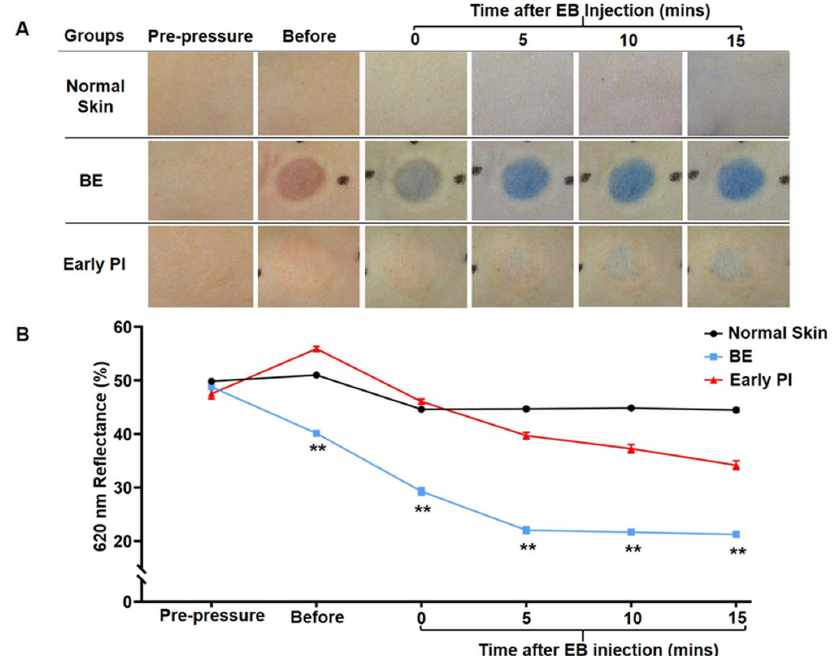
Figure 3. Analysis of BE and early PI after EB injection: ( A )representative pictures of BE and early PI before and after EB injection. EB solution was injected at 0, 5, 10, and 15 min post-decompression. Normal skin was observed as a normal reference; ( B ) reflectance represented the spectroscopic measurement of BE and early PI at 620 nm absorbance. Data are expressed as the mean ± SEM. n = 8 for each group. ** p < 0.001.